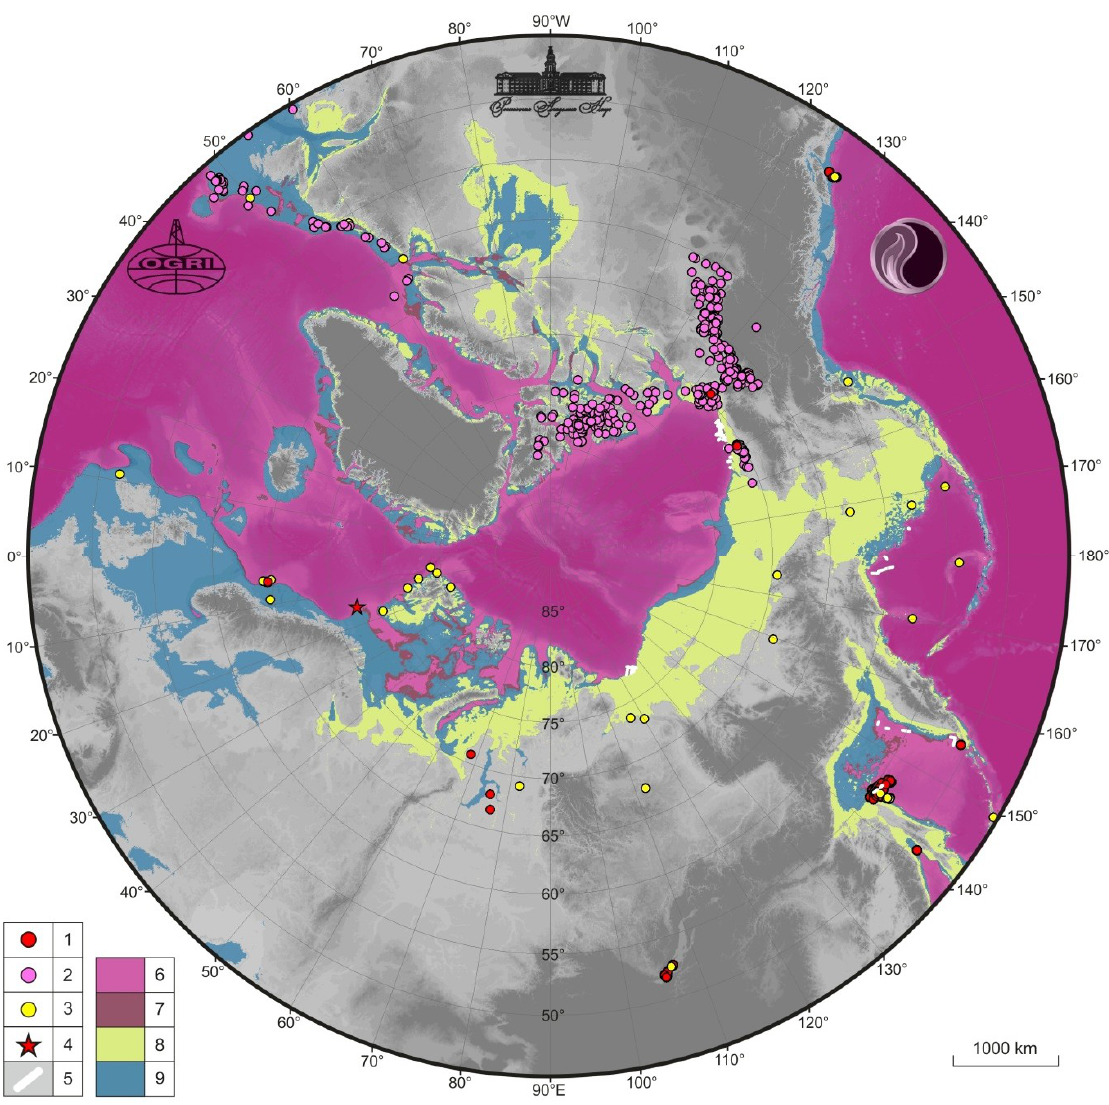
Figure 7. Scheme of probable methane hydrates (MH) distribution in the Arctic Ocean and adjacent offshore areas, limited by the 45° latitude. 1—confirmed by direct studies, including drilling, 2—predicted by log data, 3—predicted by seismic data (BSR) and other indirect evidence, 4—Haakon Mosby Mud Volcano with gas hydrates, 5—BSR observations in the Laptev, Okhotsk, Bering and Beaufort seas, 6 and 7—zones with favorable thermobaric conditions for MH existence for Models 1 and 2 respectively, 8—favorable zone for subaquatic permafrost existence, 9—absence of appropriate conditions for MH existence in offshore areas.